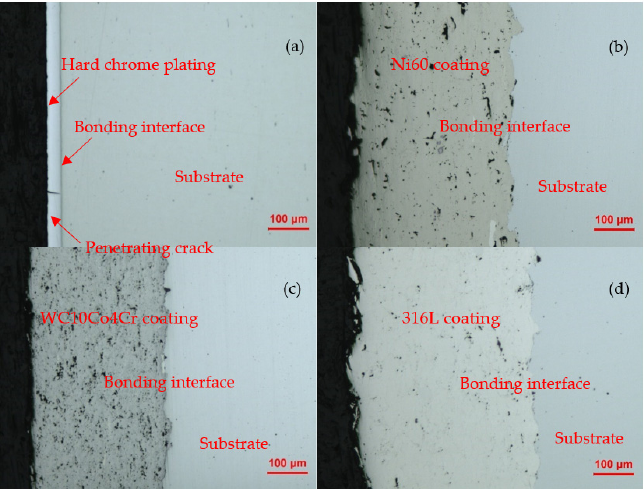
Figure 4. Metallographic of hard chrome plating and HVOF coatings. ( a ) hard chrome plating cross- section ( b ) Ni60 coating cross-section ( c ) WC10Co4Cr coating section ( d ) 316L coating cross-section.